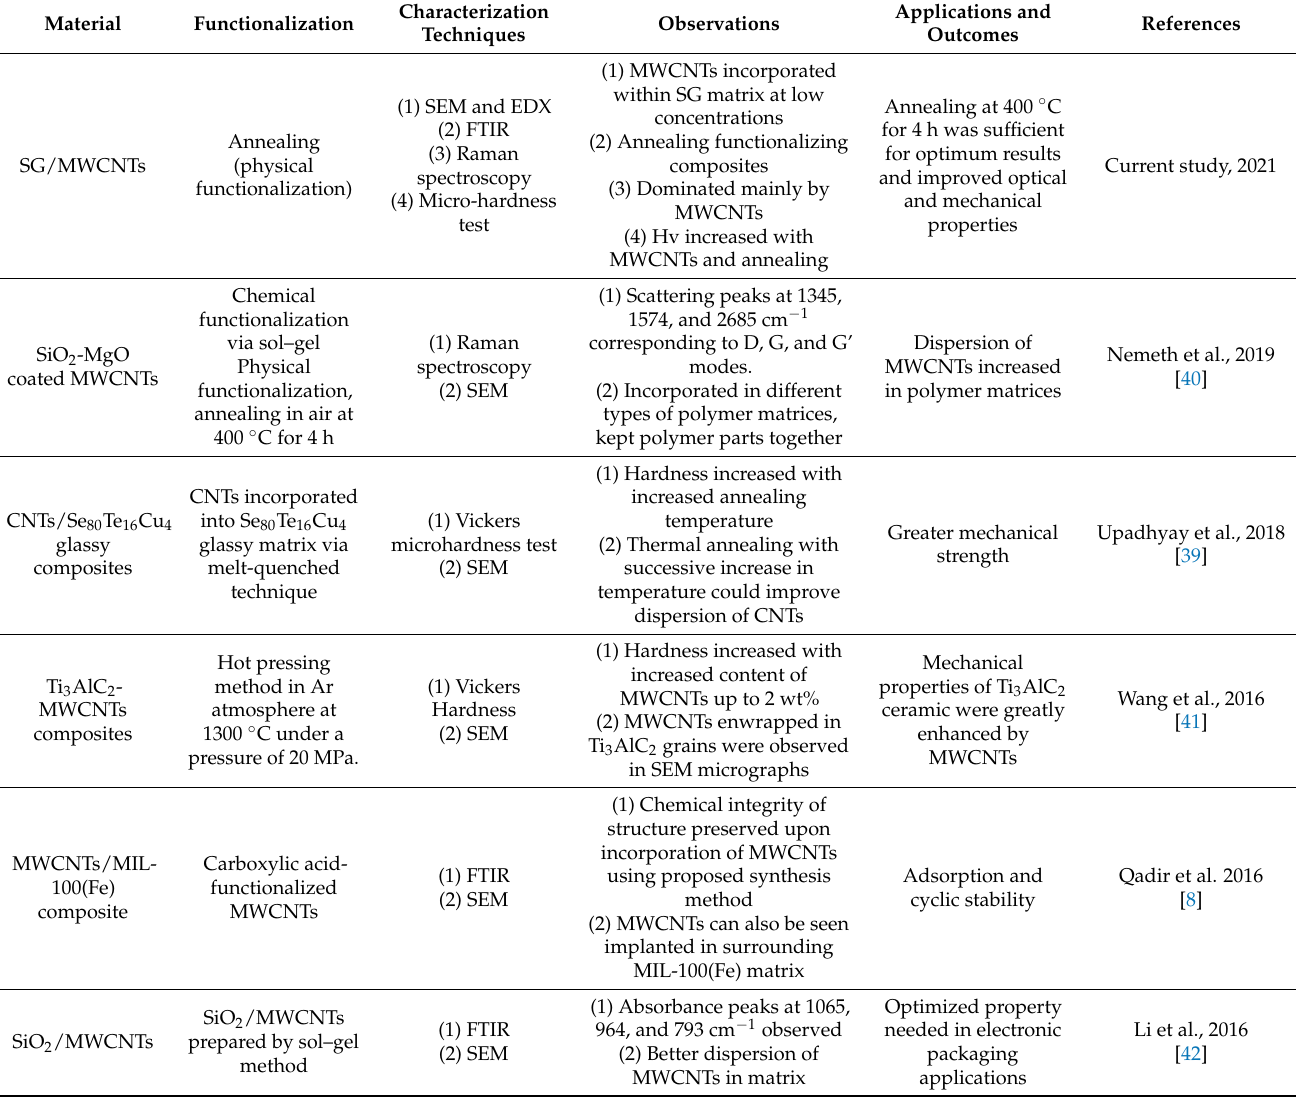
Table 4. Summary of characterizations of nanocomposites including MWCNTs in the current study and in previous work.